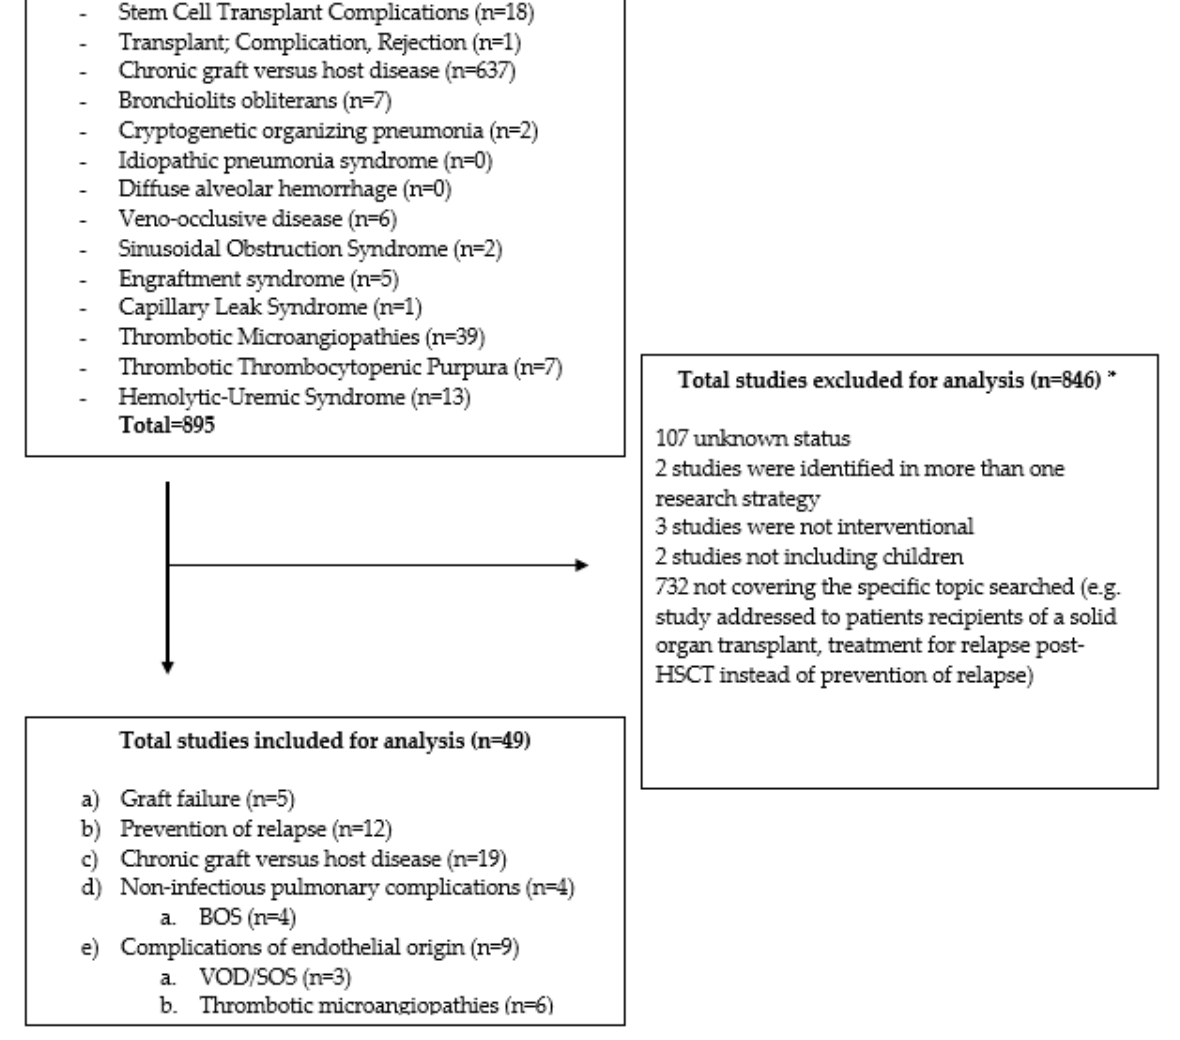
Figure 1. Flow diagram reporting the results of the search at clinicaltrials.gov (Last accessed 17 October 2022). BOS: bronchiolitis obliterans syndrome; HSCT: hematopoietic stem cell transplantation; SOS: sinusoidal obstruction syndrome; VOD: veno-occlusive disease. * Studies could be excluded for more than one reason, but they were counted only once in this figure.